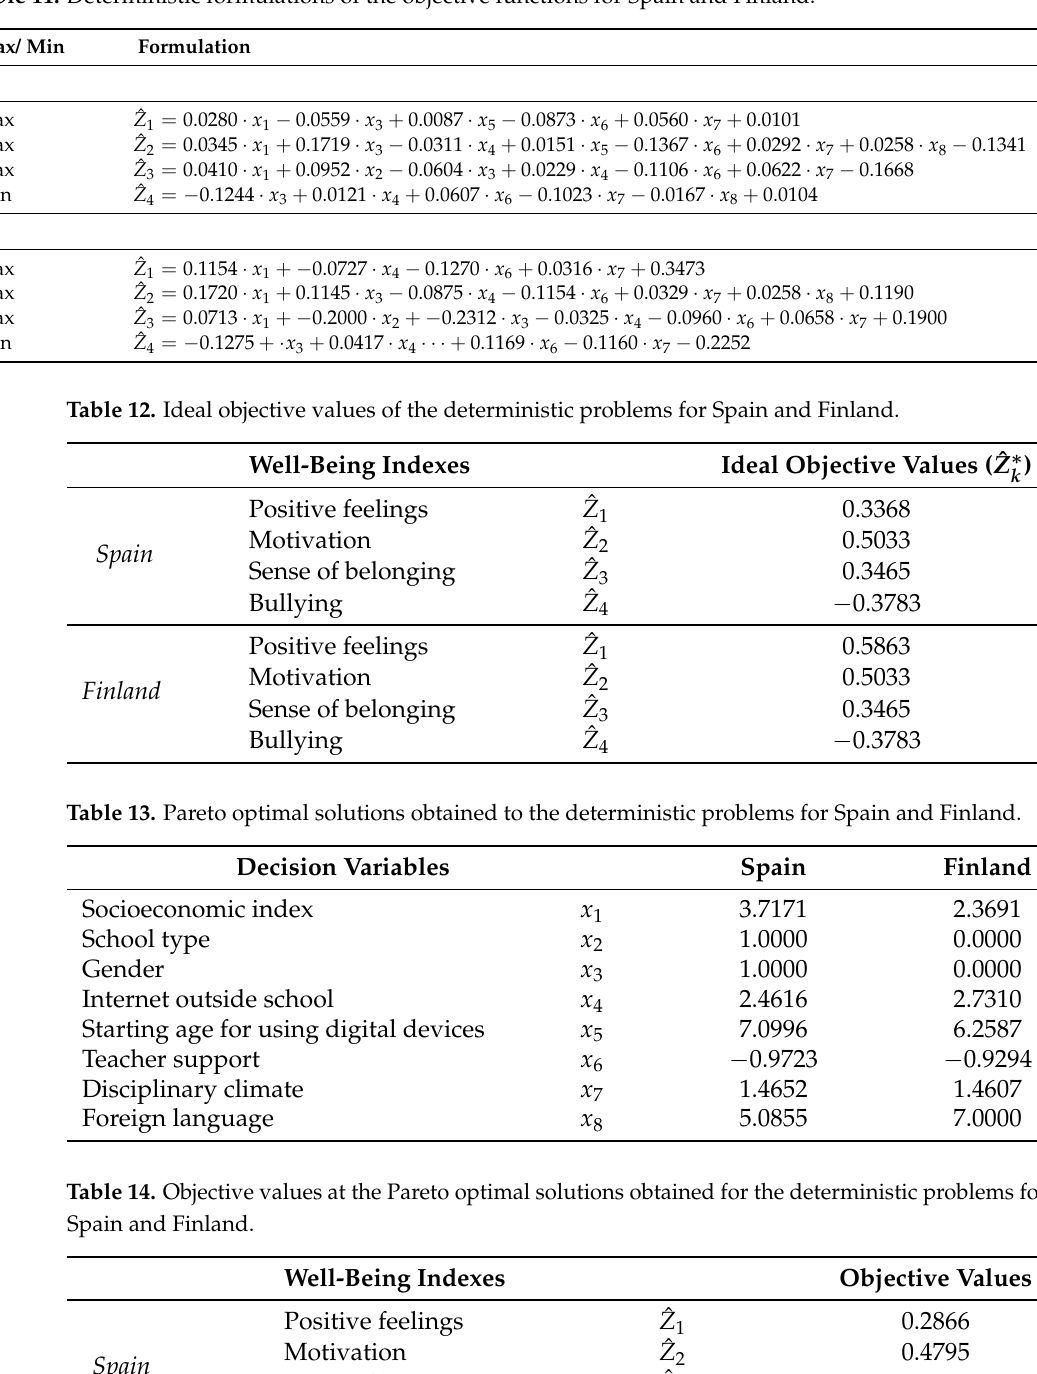
Table 11. Deterministic formulations of the objective functions for Spain and Finland.